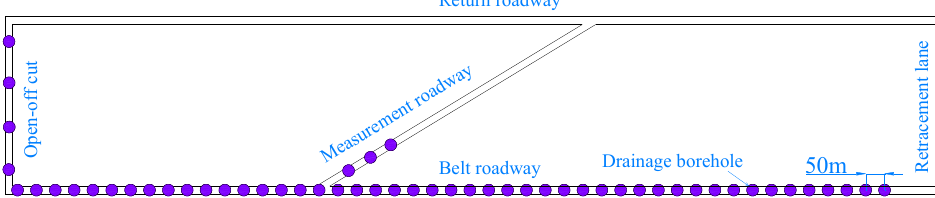
Figure 13. Layout drainage borehole.